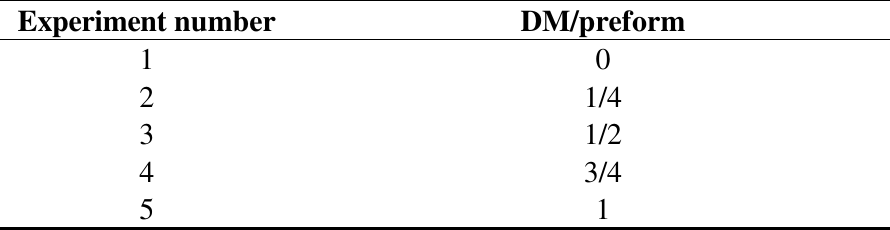
Table 4. Ratio of